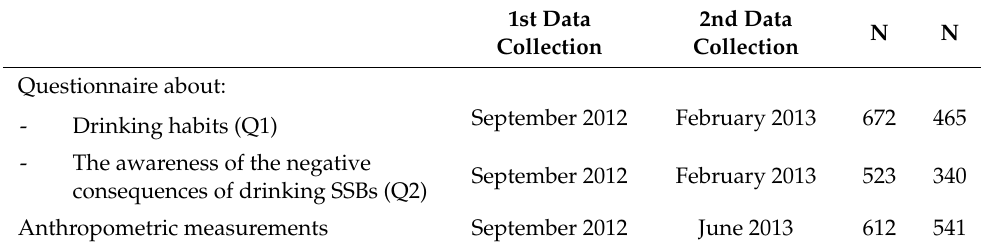
Table 3. Data collection according to interventions: active (September 2012–February 2013; 5